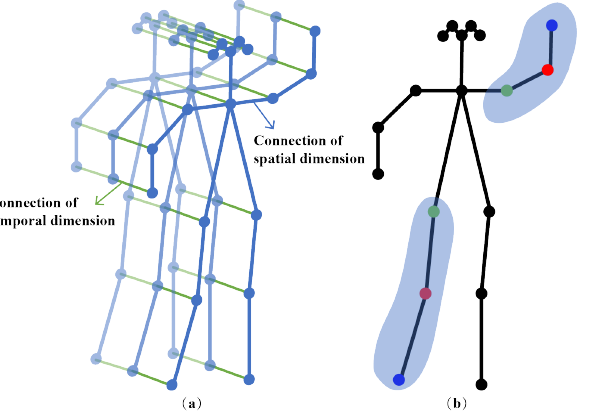
Figure 2. ( a ) The description of the spatiotemporal graph follows ST-GCN [1]; ( b ) The configuration of spatial configuration partitioning. The three colors represent three different